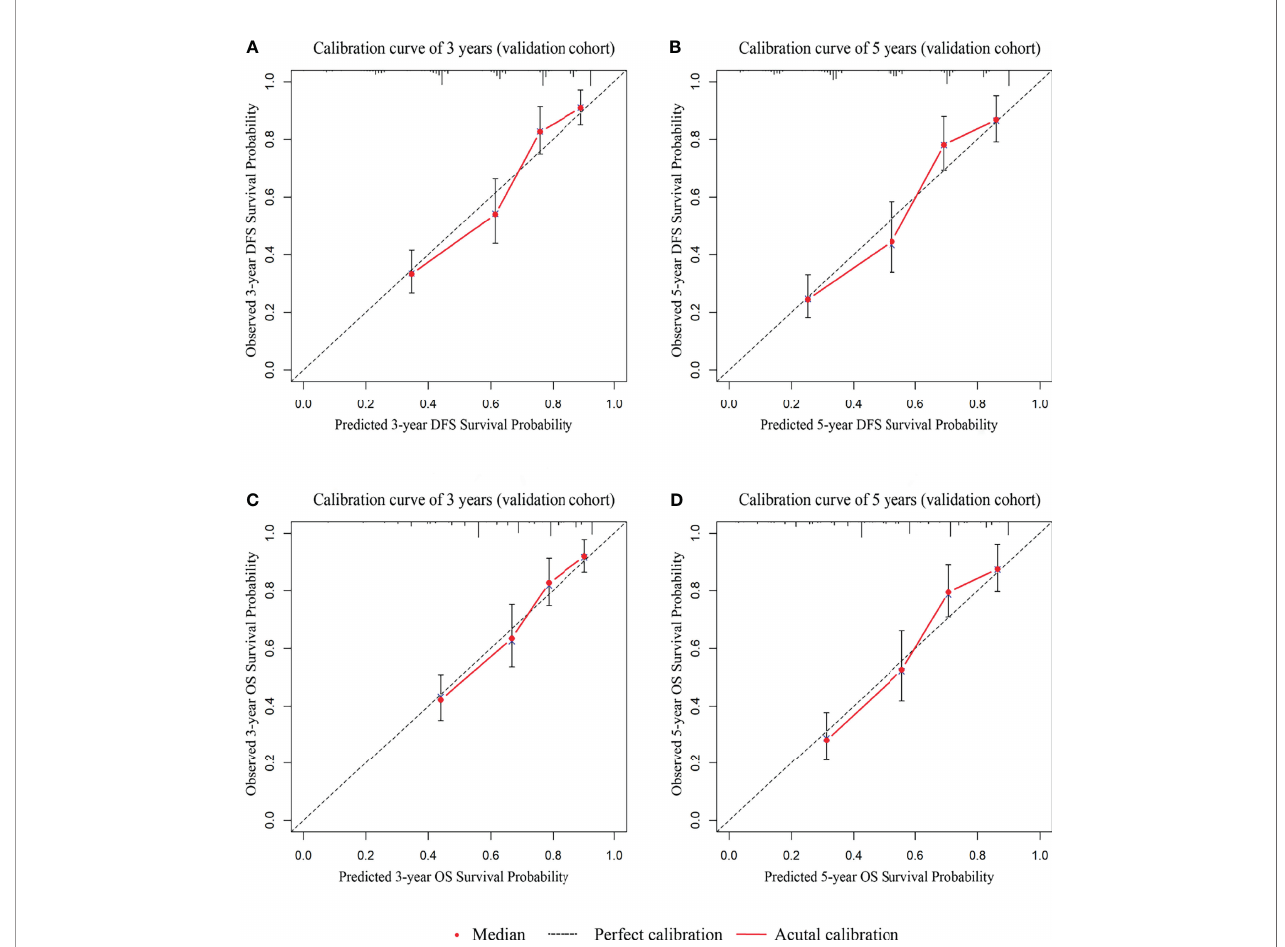
FIGURE 7 | The calibration curves for external cohort validation between predicted and observed DFS and OS outcomes. (A) The 3-year calibration curve for DFS. (B) The 5-year calibration curve for DFS. (C) The 3-year calibration curve for OS. (D) The 5-year calibration curve for